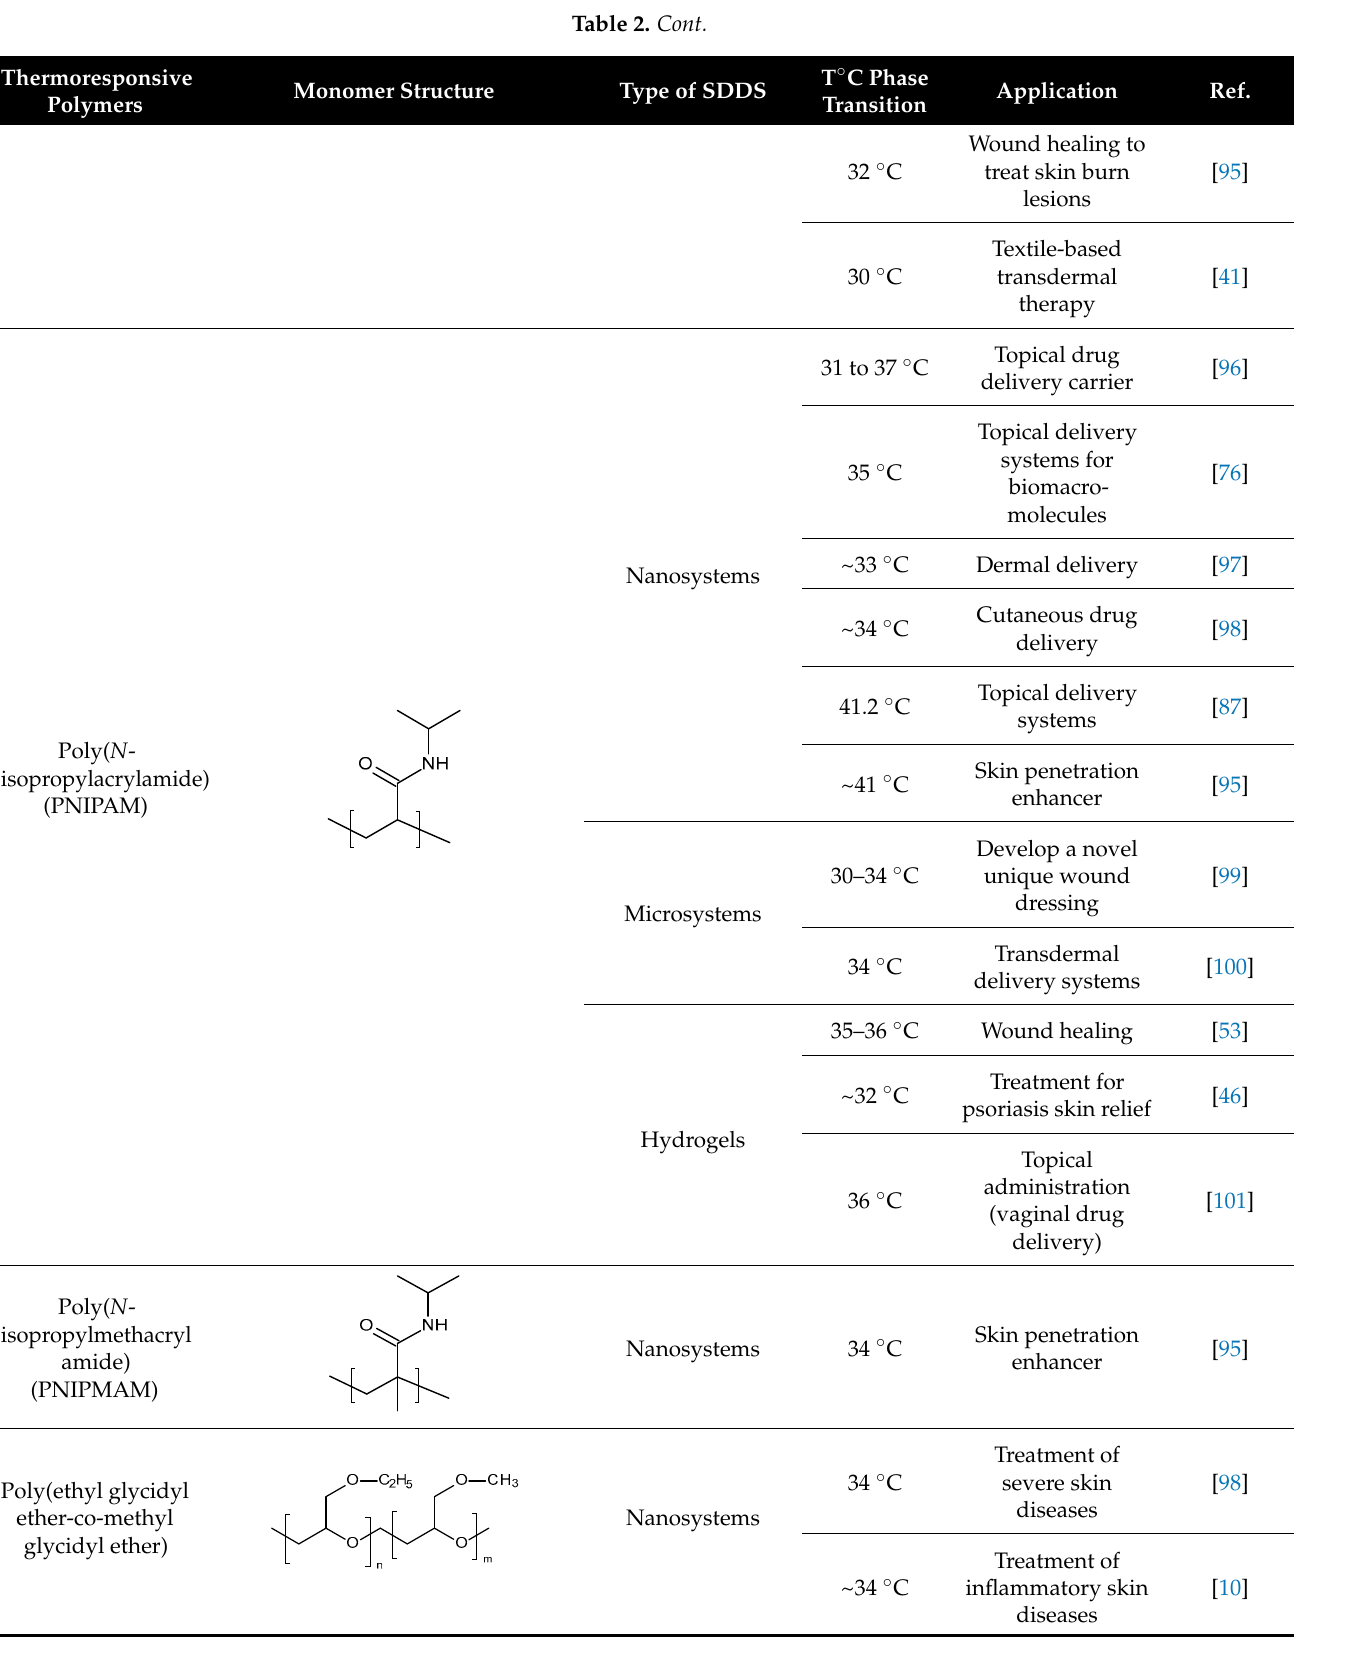
Table 2. Structure and characteristics of thermoresponsive polymers used to design smart drug delivery systems for skin